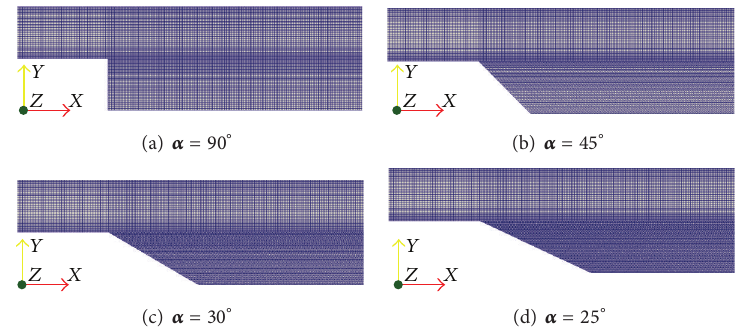
Figure 3: Backward facing step. Geometries of the four snapshots.